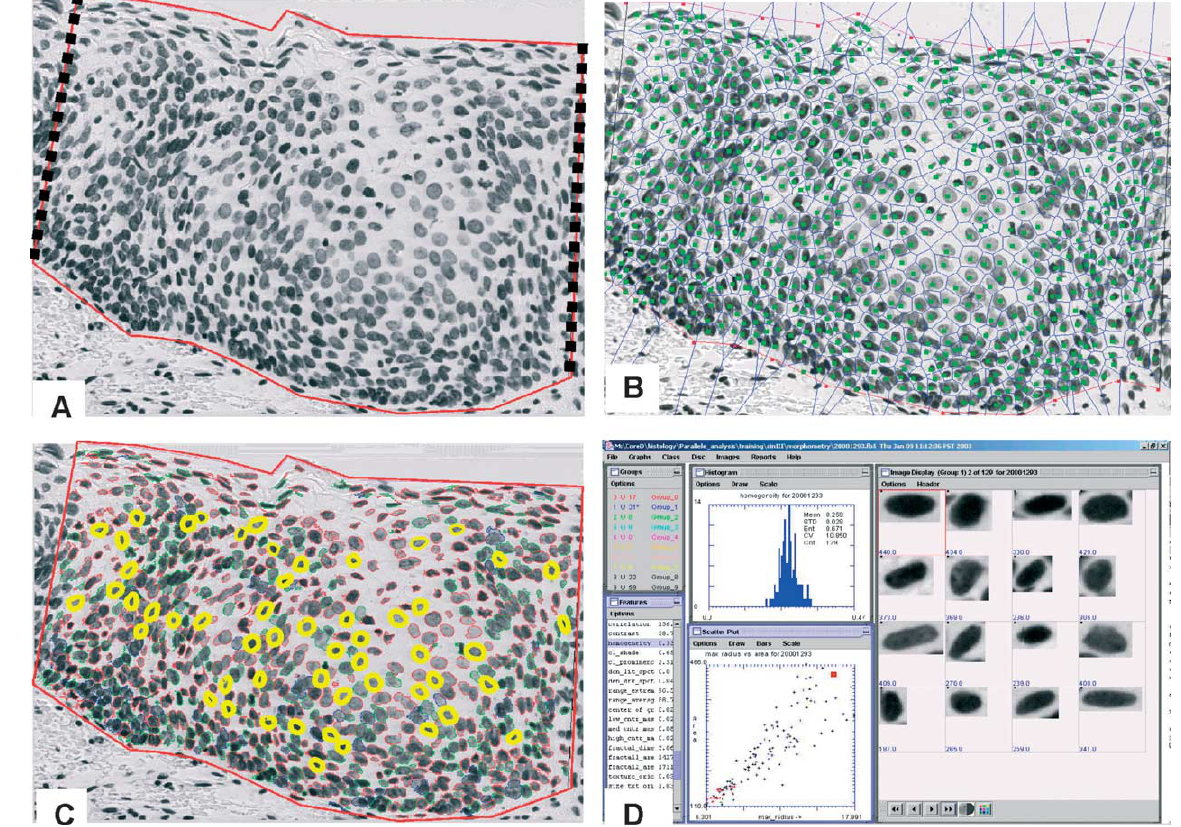
Fig. 1. Different steps of the semi-automated analysis of cervical lesions. A: Definition of the Region of Interest. B: Automatic locations of the positions of the nuclei. C: Automatic segmentation of the nuclei in the intermediate layers of the epithelium. D: Snapshot of the interface of our software used for post-analysis of the morphometric analyses (Quality